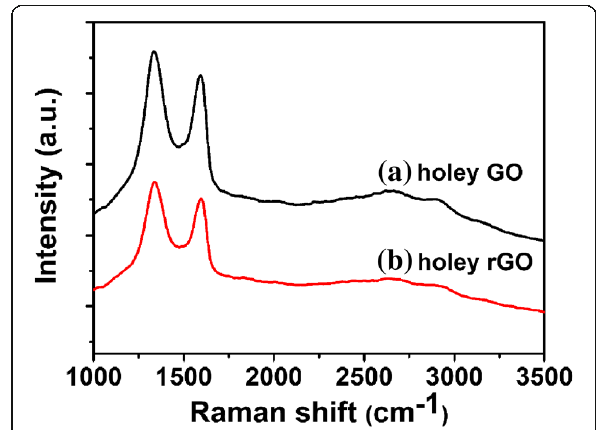
Fig. 4 Raman spectra of a HGO and b rHGO with an excitation wavelength of 632